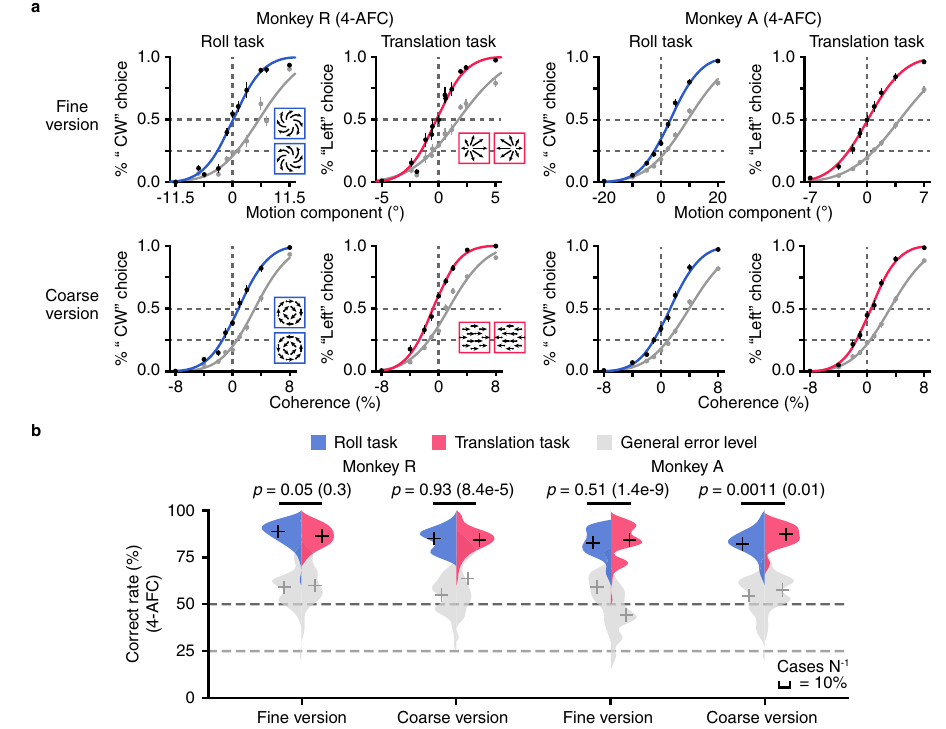
Fig. 2 | Behavioral performance in 4-AFC task for monkey R and monkey A. a Average psychometric functions for roll task (blue) and translation task (red) under fi ne and coarse versions across animals. In roll task, psychometric func- tions wereplotted fromthe proportionof “ CW fl ow pattern ” choice as a function ofthe “ rotationaxis ” (rotationcomponent θ R inthe fi neversion;coherenceinthe coarseversion).Intranslationtask,psychometricfunctionswereplottedfromthe proportion of “ Left fl ow pattern ” choice as a function of the “ translation axis ” (translation component θ T in the fi ne version; coherence in the coarse version). Color curves and black dots: only trials with correct fl ow pattern choice were included. Gray symbols: similar data format albeit including all trials in each fl ow pattern. For monkey R in fi ne-roll paradigm , n =68, μ =0.13°, σ =4.7° ( μ =0.91°, σ =6.6°forgeneralerrorpsychometricfunction,thesamehereinafter);incoarse- roll paradigm , n =51, μ =0.82%, σ =3.3% ( μ =0.61%, σ =3.7%); in fi ne-translation